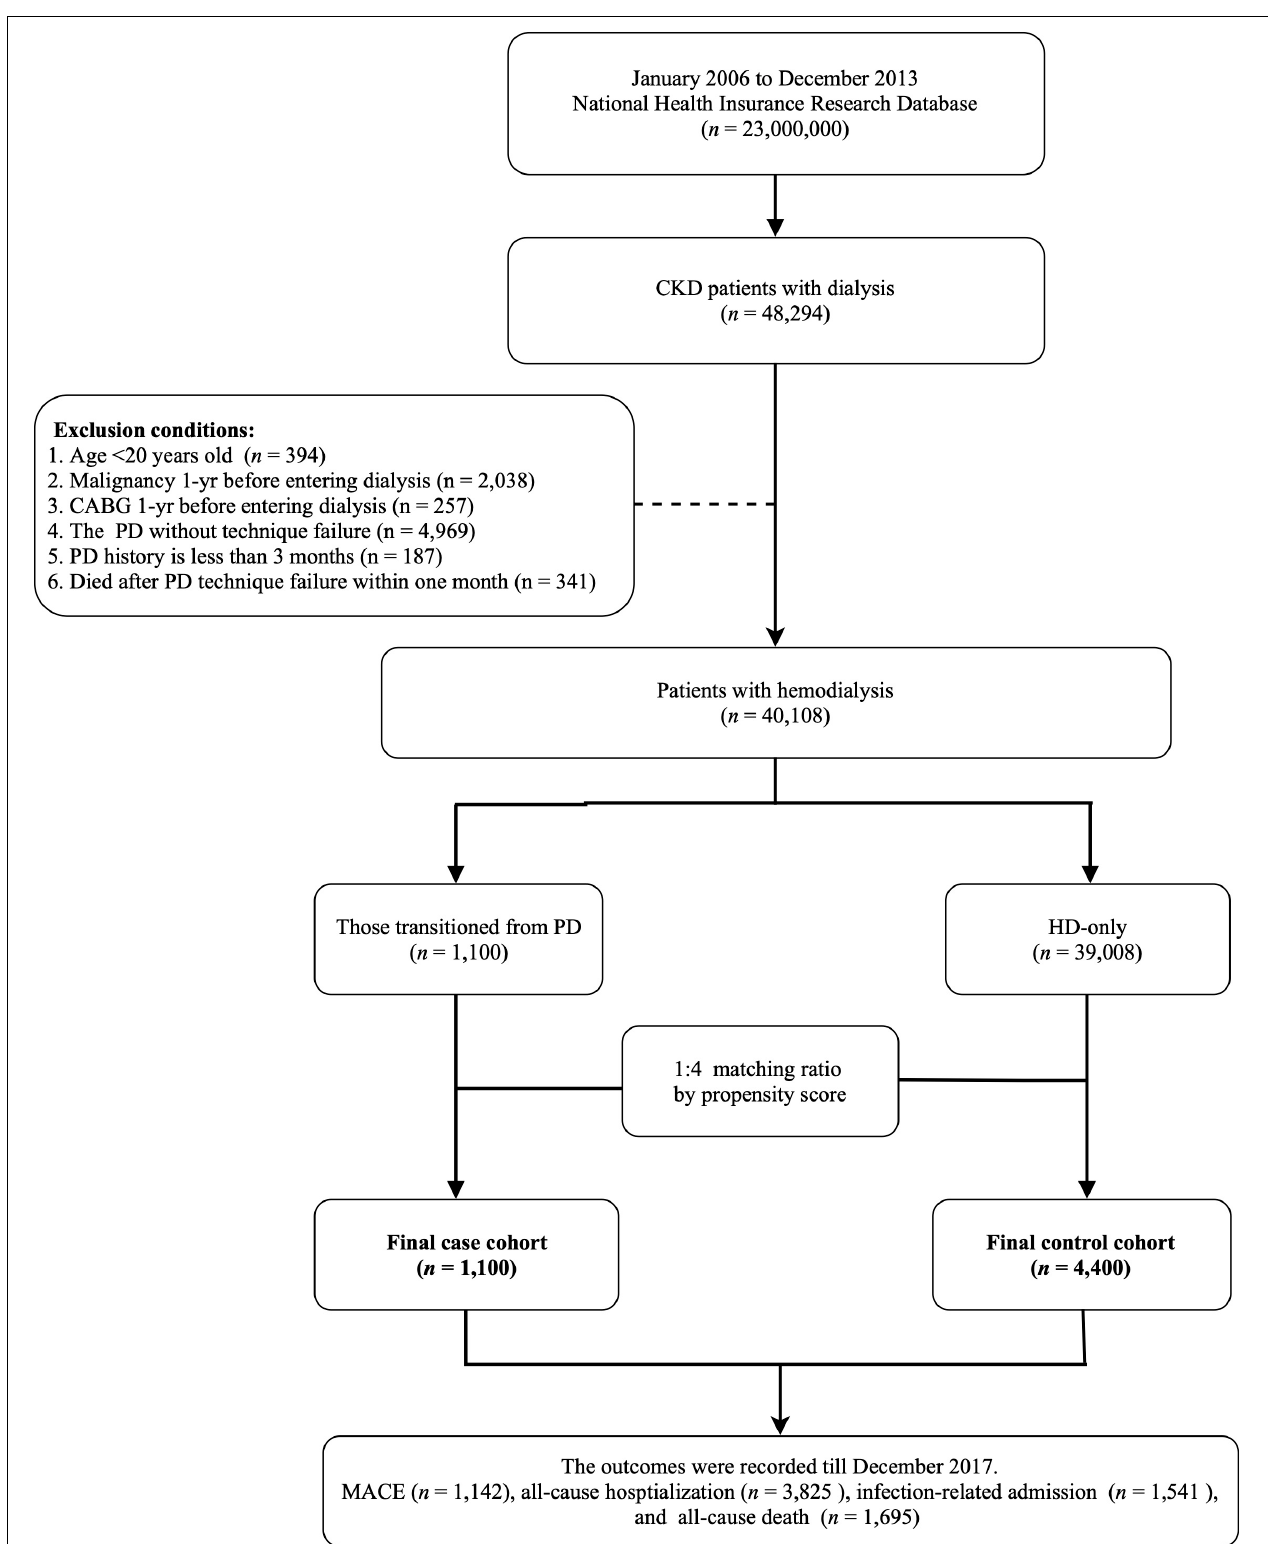
FIGURE 1 | Schematic of patient enrollment. CKD, chronic kidney disease; PD, peritoneal dialysis; CABG coronary artery bypass graft; HD, hemodialysis; MACE, major adverse cardiovascular events.